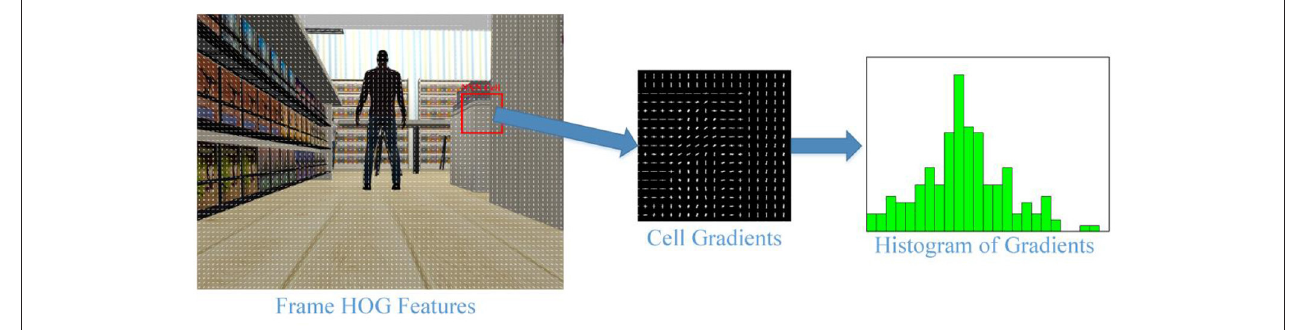
As a result of applying KF-based tracking to our dataset, the tracking of a detected customer is shown in some frames in Figure 5 . As a result of detection and tracking, the human can be followed by the ground robot. In the frames shown in Figure 5 , the human position is labeled as “Corrected” since the prediction-measurement steps are performed in the tracking process with KF after human detection. That is, in the frames where the human position is calculated with HOG-SVM,